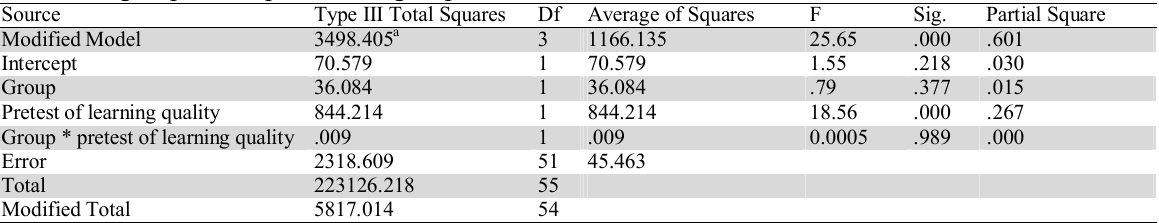
The results of Table 1 show that experimental group maintain higher level of learning (Mean = 67.1 Standard deviation = 8.44 ) than traditional education (Mean = 51.53 Standard deviation = 5.27). Table 2 presents the results of one-way analysis of covariance (ANCOVA) between pre and post-test groups. The results of one-way ANCOVA in dependent variable of learning quality in the scores of posttest of control group and experimental group